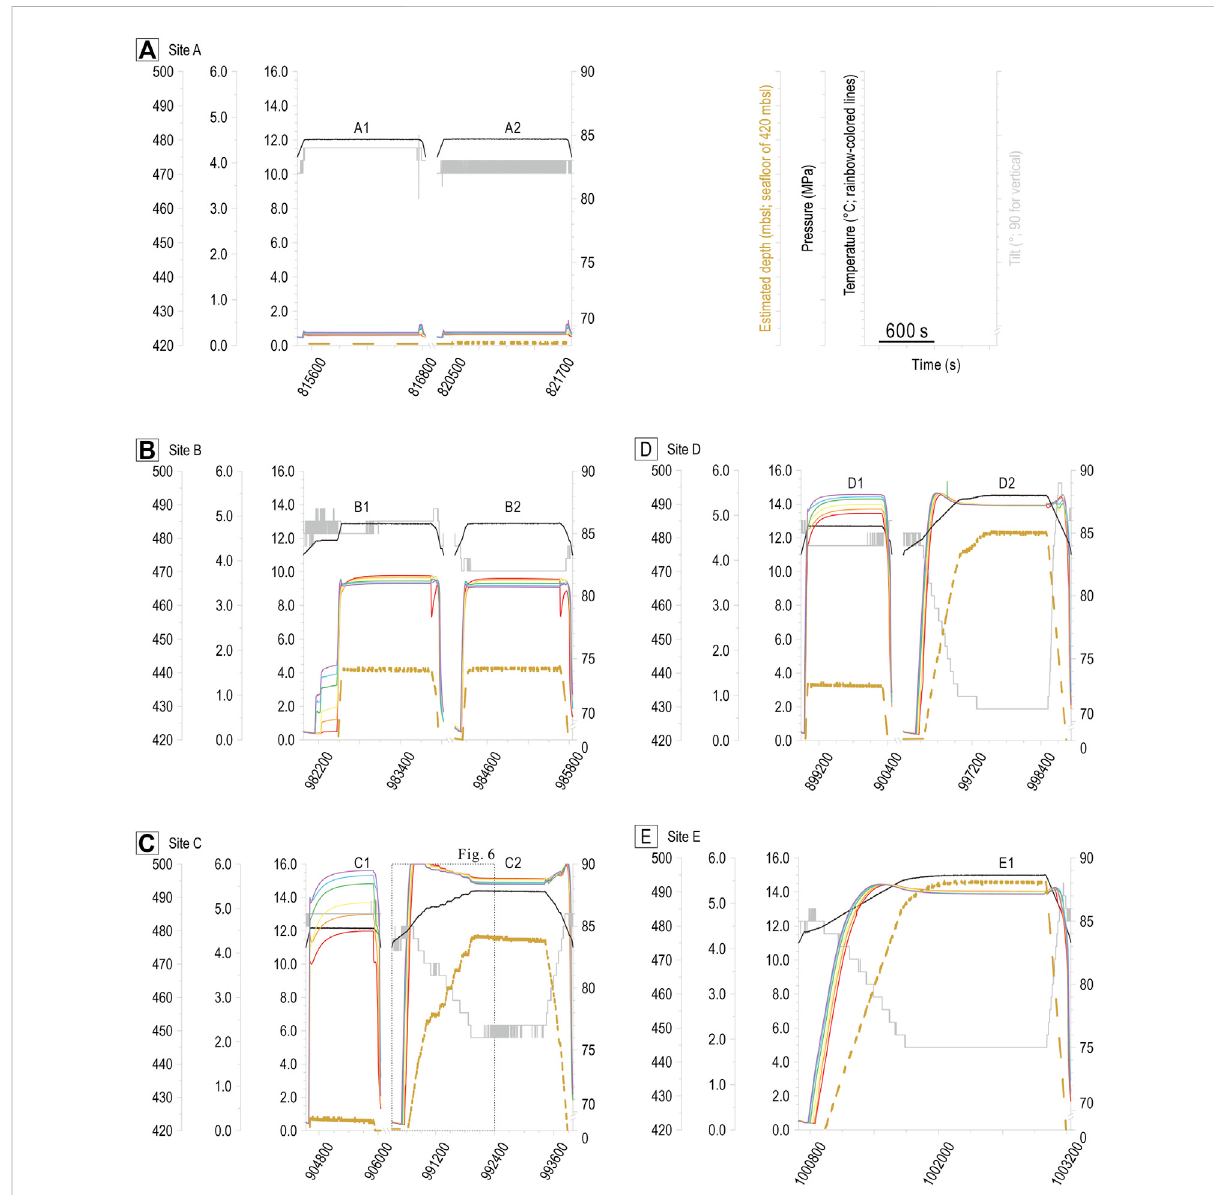
FIGURE 7 The observed results of temperature (rainbow-colored lines the same as the MTLs in Figure 2A), tilt (black line), and pressure (gray line) are represented over time when the probe is within sediments. All vertical scales are the same through the Figure subsets. Except Site (E) , two measurementswereperformedforeachsite.InSites (A) and (B) ,thosearemadeconsecutivelyonceatasite,whereasinSites (C,D) ,theyaremadeby revisitingthesites(Table1).Thetimegapbetweenmeasurementsateachsiteisshown.Estimatedpenetratingdepthoftheheatprobeisshown as the gold dashed line. Details of Observation C2 is shown in Figure